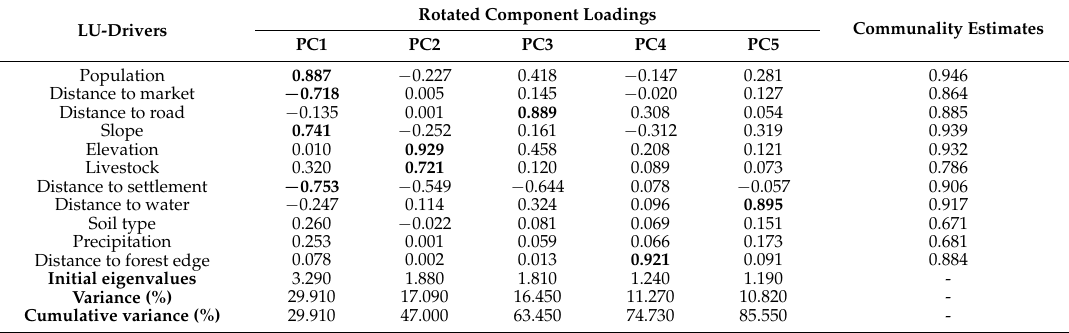
Rotated Component Loadings